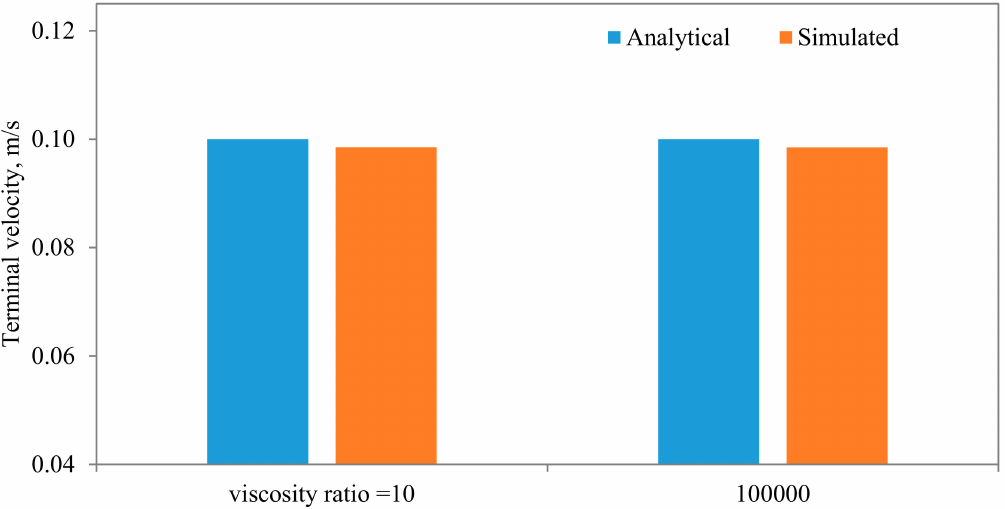
Figure 17. Comparisons between the terminal settling velocity and the simulated one for different viscosity ratios. In these simulations, the following parameters are held fixed: k x = d/L x = 4, µ f = 0.001 Pa · s, Mesh density n x = 40, n y = 80.